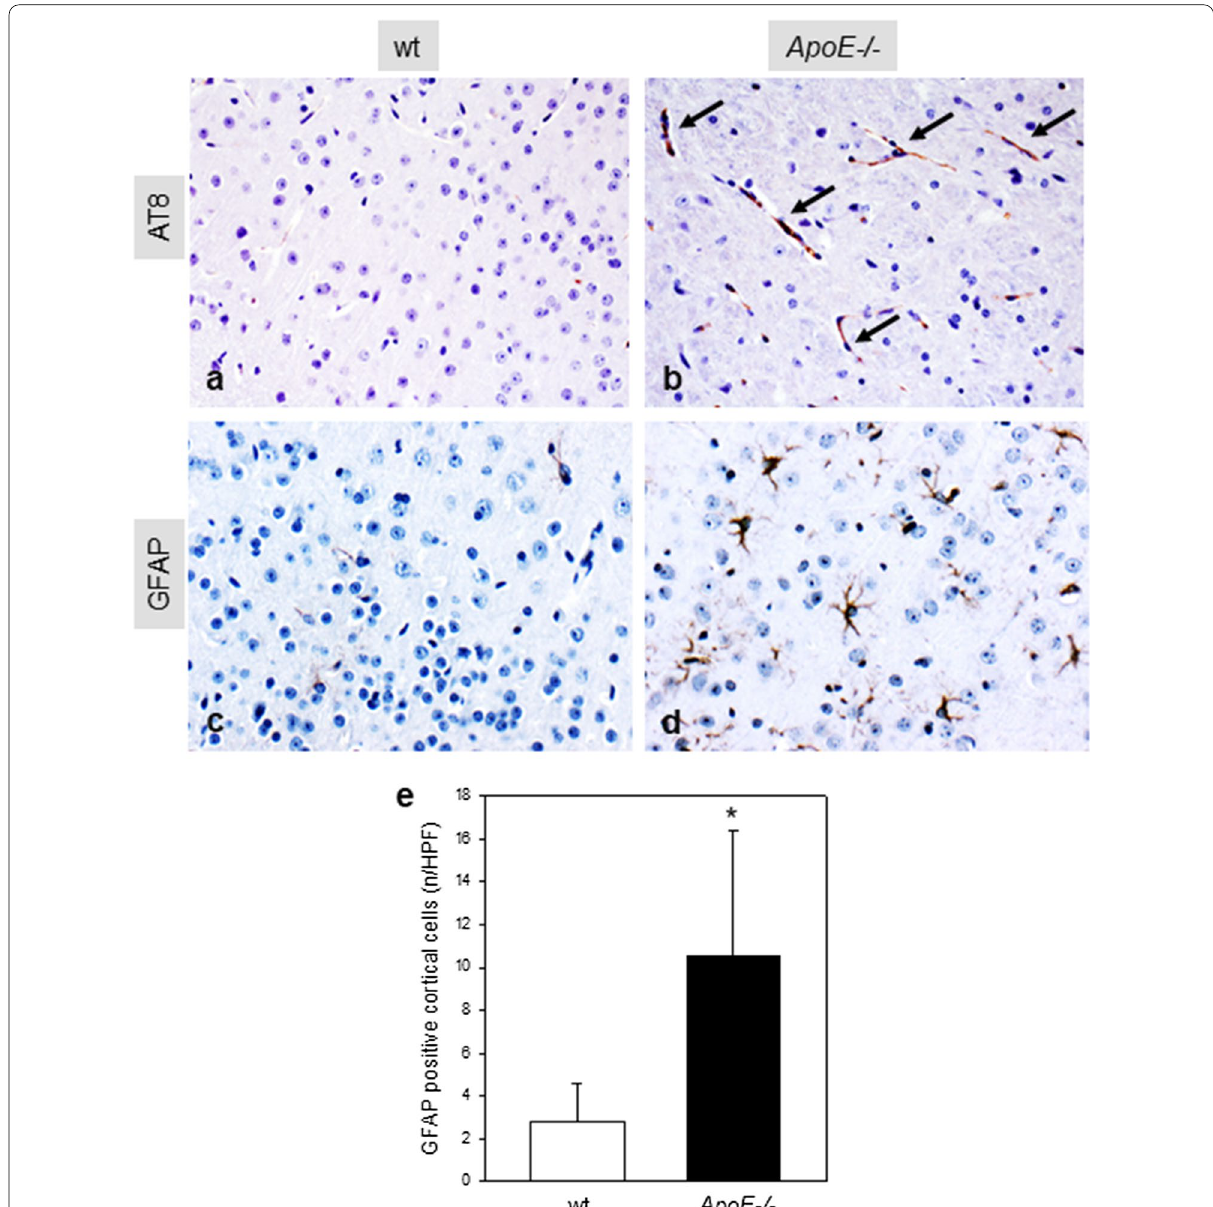
Fig. 5 Representative immunohistochemical images (original magnification of each 55 weeks old wild type (wt; a , c ) and Apolipoprotein E-deficient ( ApoE GFAP-positive cells ( e , n 8 of each mouse strains) given as number per high power field (HPF). Values are given as means = test followed by Mann–Whitney Rank sum test: * p < 0.05 versus